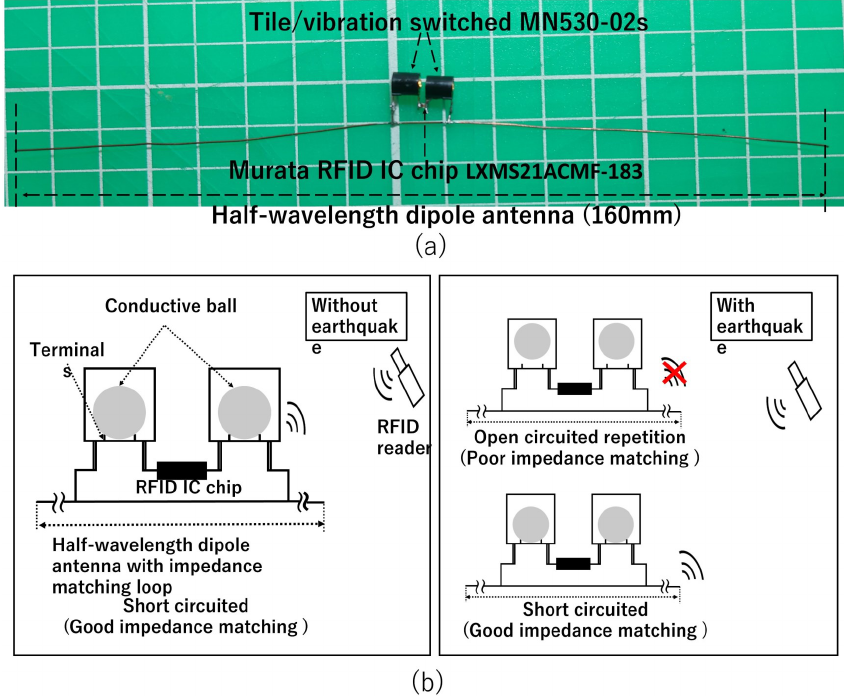
Figure 2. Operational principle of RFID-based vibration and physical-shock monitoring using tilt switches. ( a ) Entire RFID sensor tag; ( b ) operational principle of an RFID sensor system.